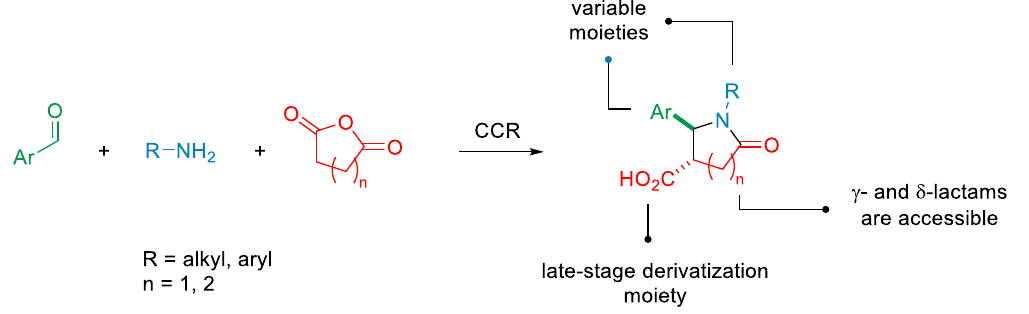
Figure 2. Papers published per year. Source Scopus (31 October 2020), key words “lactams” and “medicinal chemistry”